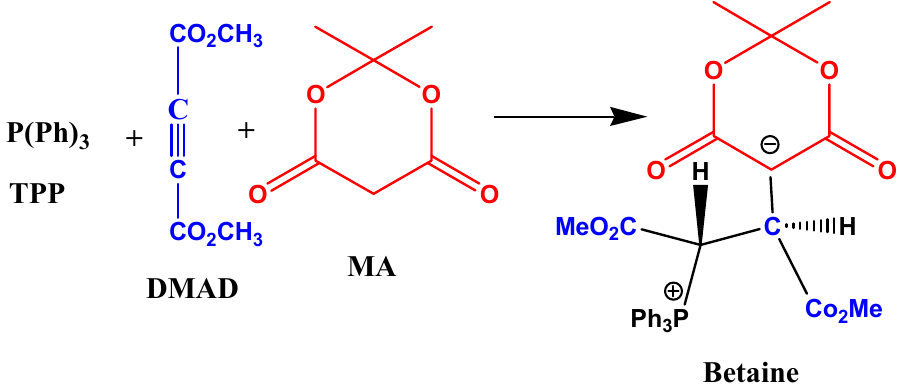
Figure 1. The reaction between triphenylphosphine (TPP) and dimethyl acetylenedicarboxylate (DMAD) in the presence of Meldrum’s acid (MA) for the generation of 1,4-diionic organophosphorus (betaine). Meldrum’s acid (MA) and 1,3-dimethylbarbituric acid (BA) have considerably higher